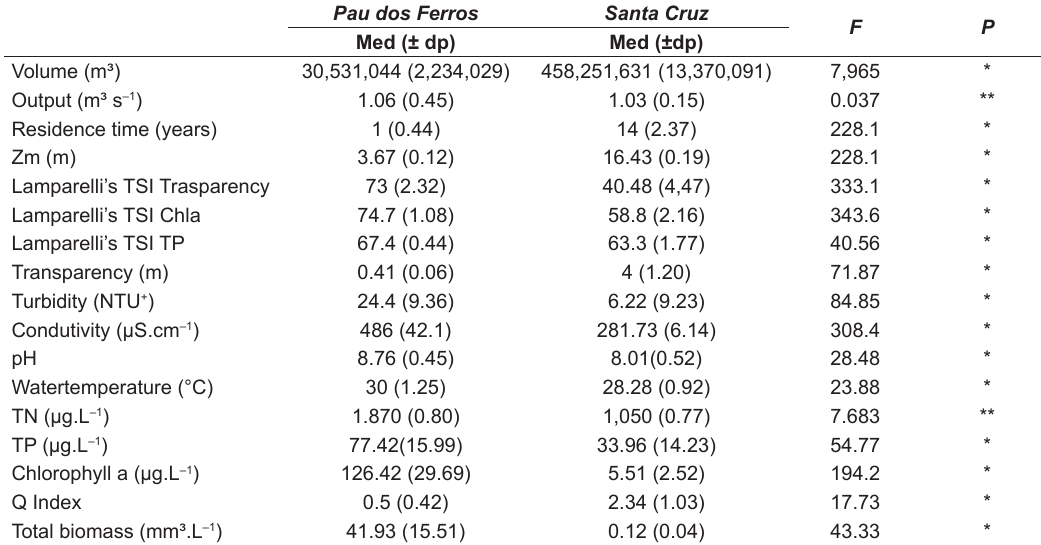
Table 1. Mean values (± standard deviation) of environmental variables and outcome of ANOVA to test differences between Santa Cruz do Apodi and Pau dos Ferros reservoirs during the study.